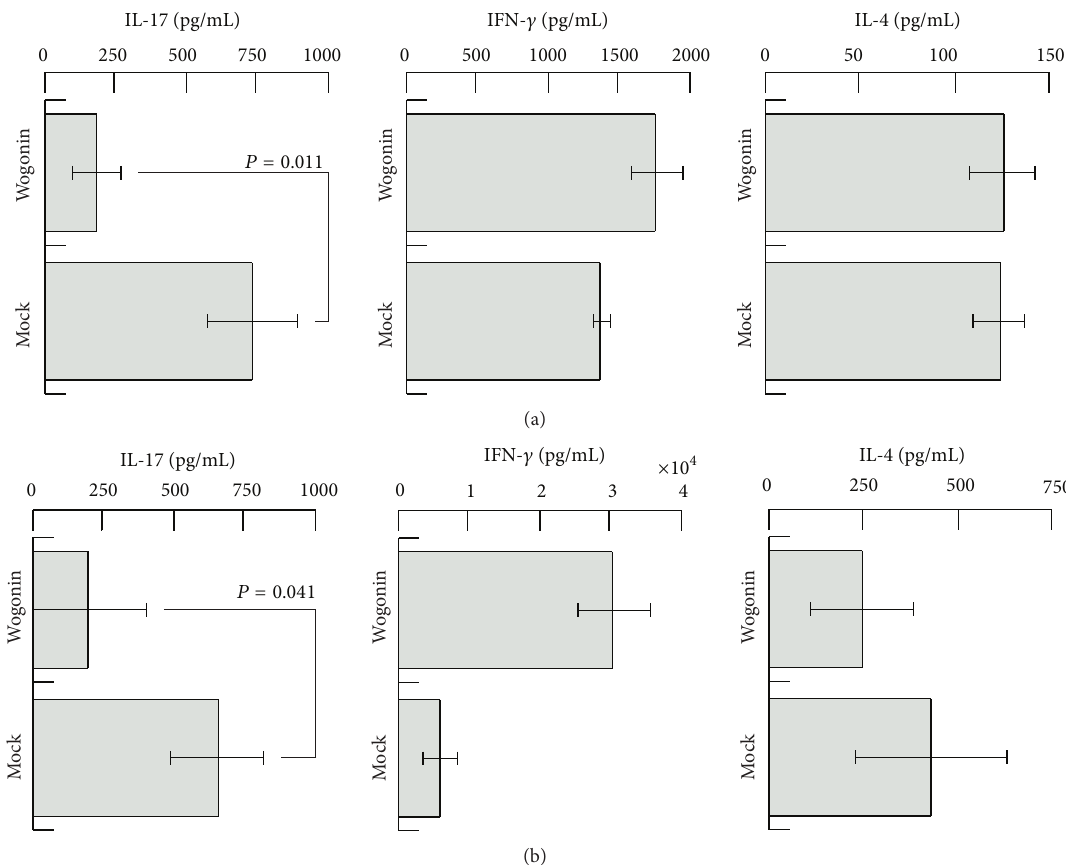
Figure 3: Suppression of IL-17 by wogonin treatment in the human MLR. For the human two-way MLR (a), wogonin (1 𝜇 M) was exposed to a mixture of human allogeneic lymphocytes and then incubated for seven days. Seven days after incubation, the supernatants were analyzed using ELISA to detect the typical cytokines of IFN- 𝛾 (center), IL-4 (right), and IL-17 (left) for Th1, Th2, and Th17, respectively. For the human one-way MLR (b), wogonin (1 𝜇 M) was incubated with human Mo-DCs for two days. Then, the wogonin-treated human Mo-DCs were incubated with human allogeneic na¨ıve CD4 + T cells in the absence of wogonin for seven days. The cells were restimulated with anti-human CD3 and CD28 antibodies for 24 h, and the supernatants were collected for ELISA to detect the typical cytokines of IFN- 𝛾 (center), IL-4 (right), and IL-17 (left) for Th1, Th2, and Th17,